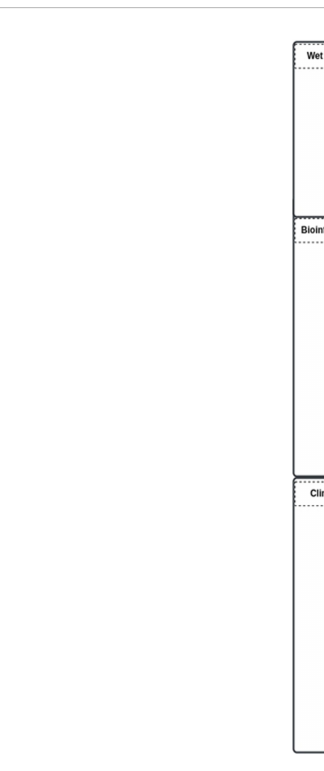
FIGURE 3 Schematic work fl ow from sample to clinical